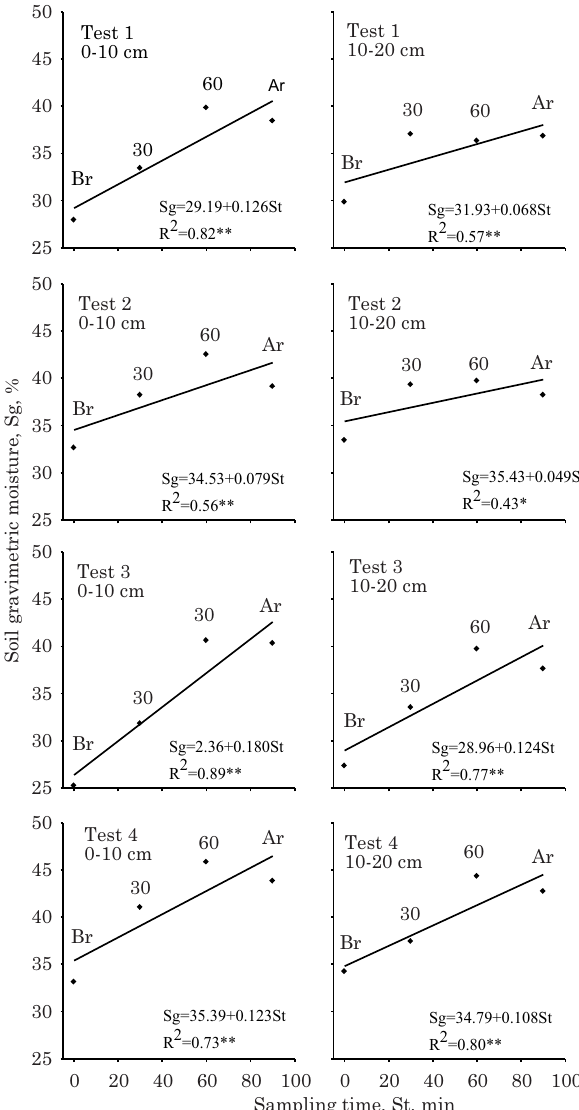
Figure 4. Relation between soil gravimetric moisture, Sg, and sampling time, St, in two soil layers, for four rainfall tests, on a Humic Dystrudept soil (average of treatments and replicates). Br: before the rainfall; 30 and 60: 30 min and 60 min after the rainfall began, respectively; Ar: after the rainfall